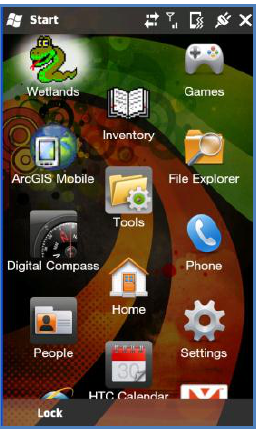
Figure 4. Illustration of the wetlands mobile GIS interface with the HTC HD2 mobile phone.